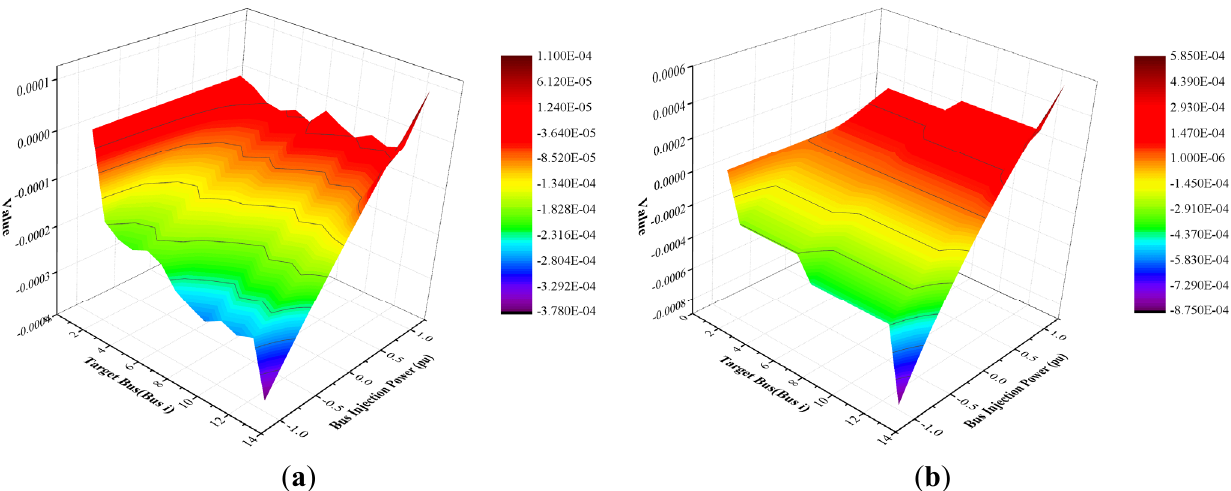
Figure 7. The results of Equation (38) as a function of the injected power at the